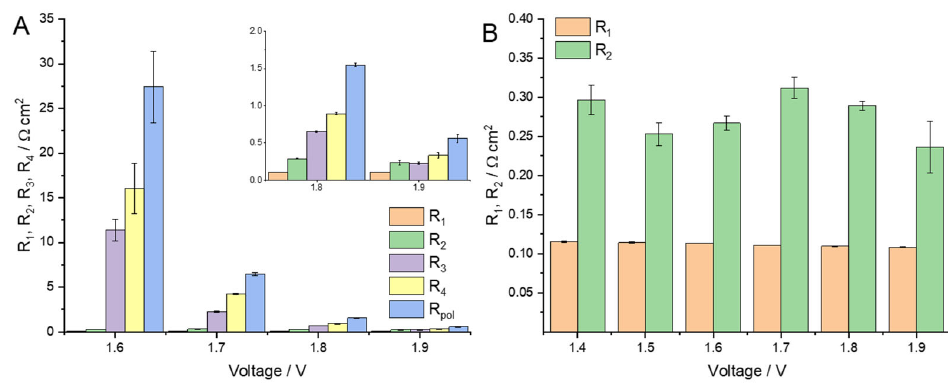
Figure 3. The MEA resistance components R 1 –R 4 variation with the cell voltage ( A ) and the comparison of only R 1 and R 2 values ( B ).